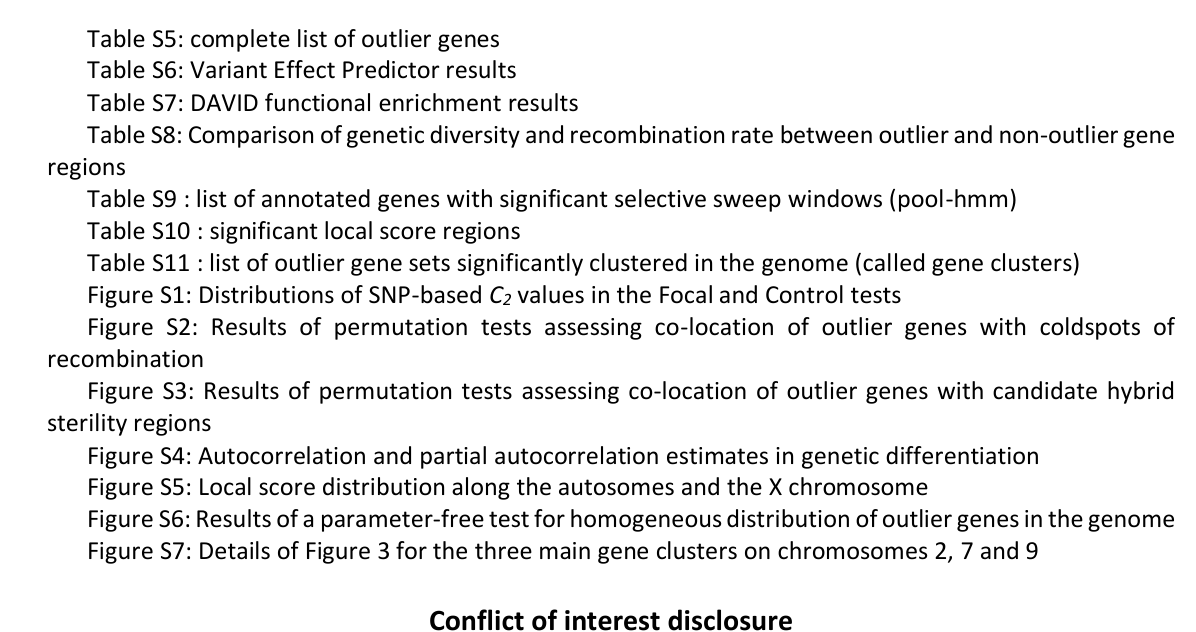
Table S5: complete list of outlier genes Table S6: Variant Effect Predictor results Table S7: DAVID functional enrichment results Table S8: Comparison of genetic diversity and recombination rate between outlier and non-outlier gene regions Table S9 : list of annotated genes with significant selective sweep windows (pool-hmm) Table S10 : significant local score regions Table S11 : list of outlier gene sets significantly clustered in the genome (called gene clusters) Figure S1: Distributions of SNP-based C 2 values in the Focal and Control tests Figure S2: Results of permutation tests assessing co-location of outlier genes with coldspots of recombination Figure S3: Results of permutation tests assessing co-location of outlier genes with candidate hybrid sterility regions Figure S4: Autocorrelation and partial autocorrelation estimates in genetic differentiation Figure S5: Local score distribution along the autosomes and the X chromosome Figure S6: Results of a parameter-free test for homogeneous distribution of outlier genes in the genome Figure S7: Details of Figure 3 for the three main gene clusters on chromosomes 2, 7 and 9 Conflict of interest